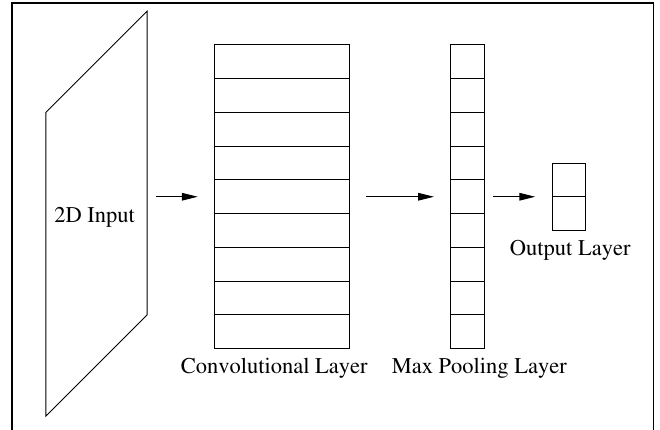
Figure 1. The Convolutional Neural Networks (CNN) architecture used in this work. From left to right are shown a two-dimensional input layer, a convolutional layer, a max-pooling layer, and an output layer which is fully connected.